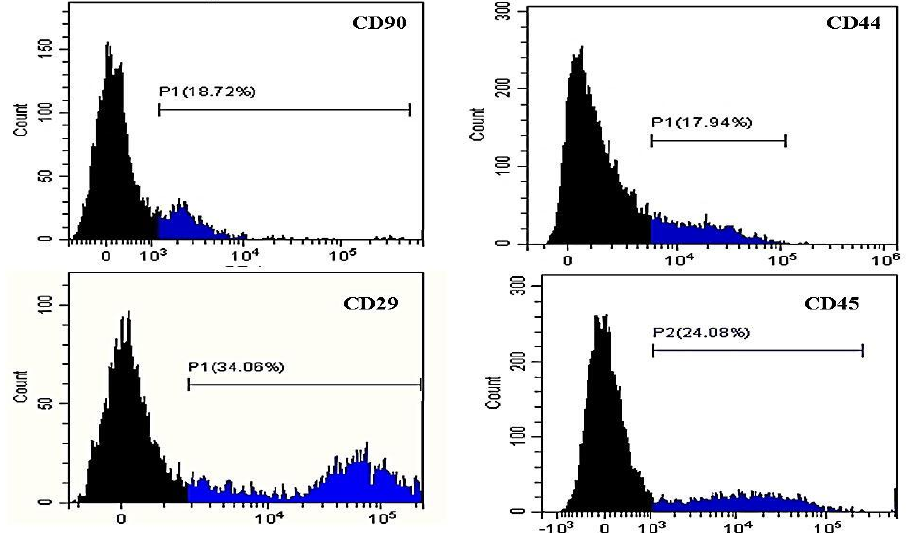
Figure 4. Results of flow cytometry assay of canine SVF cells isolated from the falciform ligament AT stained with PE-conjugated anti-CD90, anti-CD44, anti-CD29, and FITC-conjugated anti-CD45. Black areas indicate negative areas. The percentage represents gated positive areas.